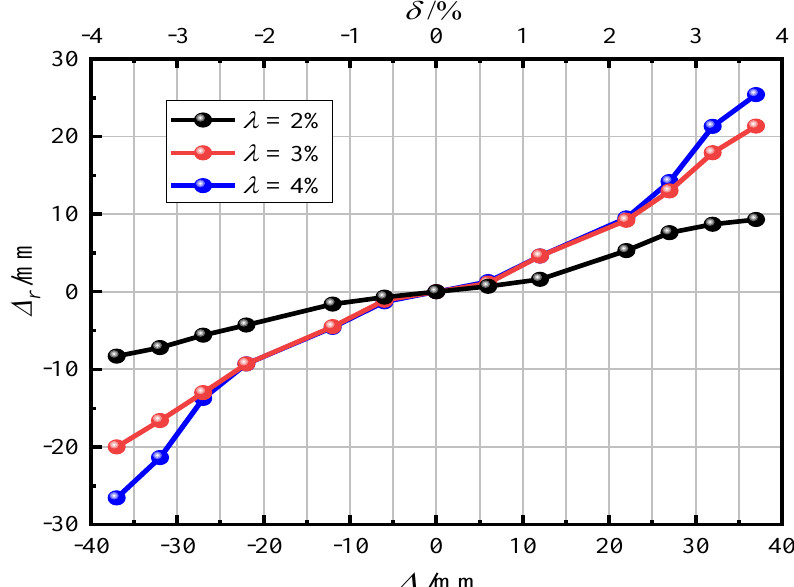
Figure 12. Residual displacement.